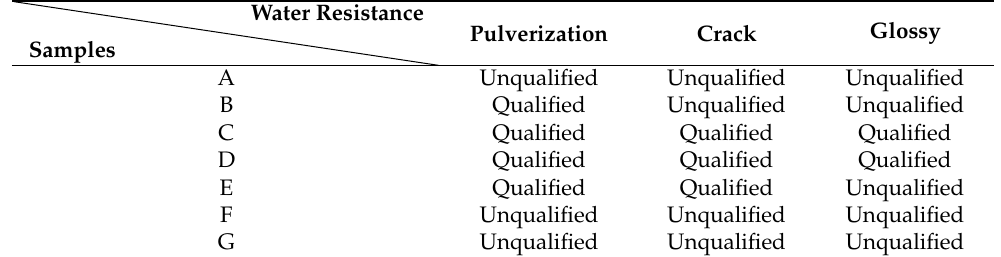
Table 3. Water resistance of coatings with different ratios of anhydride and hydroxyl groups in EB. Water Samples